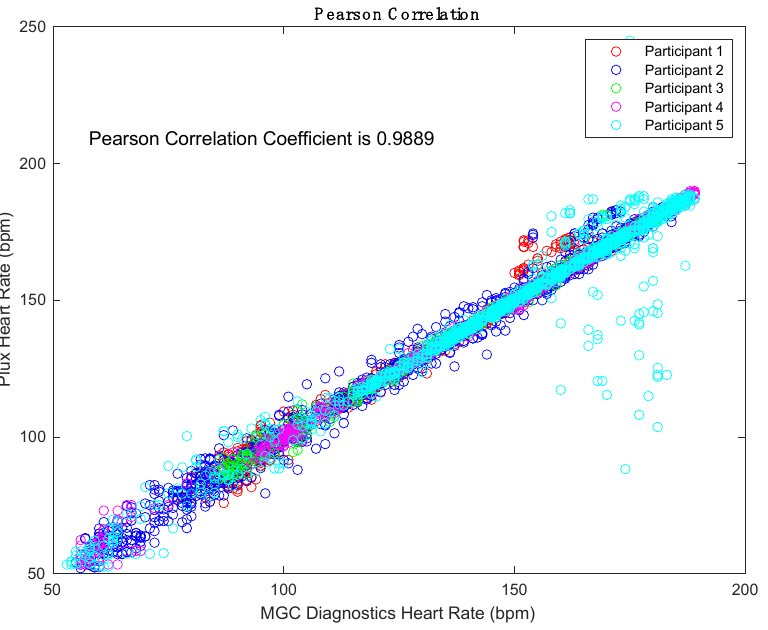
Figure 2. Pearson Correlation comparing PluxECG and the lab-based 12-lead ECG system heart rate measurement for the Ramp Protocol.